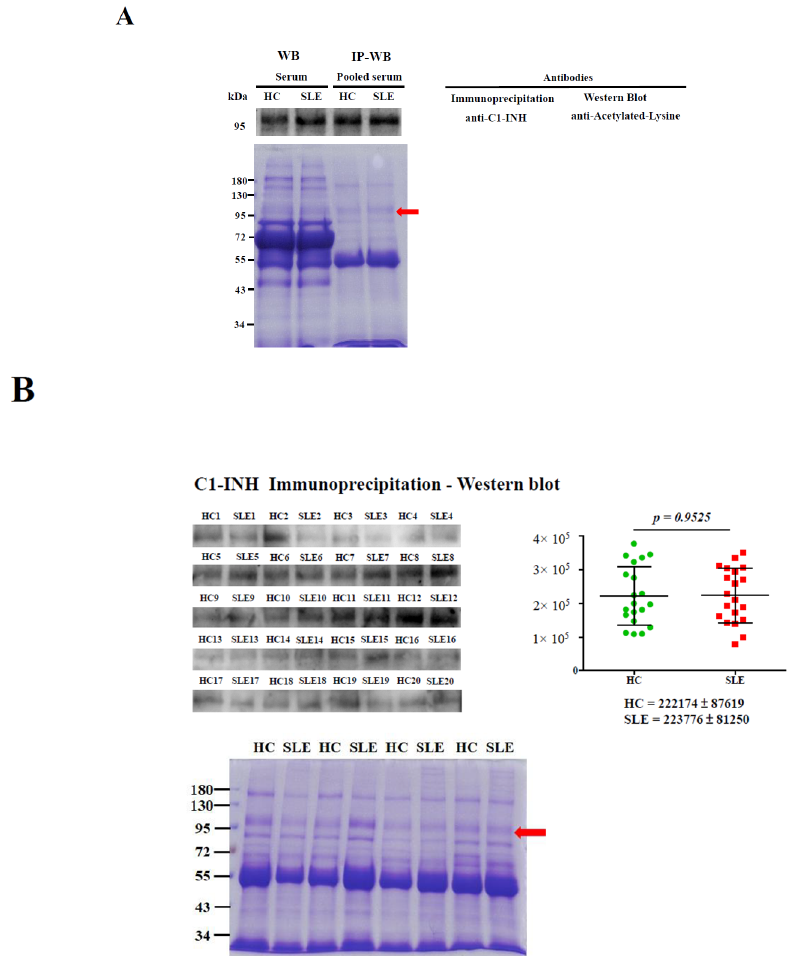
Figure 2. Acetylation modification of the C1-inhibitor (INH) validated using immunoprecipitation (IP) and Western blotting. The percentage of sodium dodecylsulfate polyacrylamide gel electrophoresis (SDS-PAGE) gel was 8%, and IP loading amount of serum proteins was 100 µ g of IgG-removal serum proteins. The C1-INH was immunoprecipitated from pooled serum samples (20 healthy controls (HCs) and 20 patients with systemic lupus erythematosus (SLE)) using an anti-C1-INH antibody, and samples were then subjected to Western blotting with an anti-acetylated-lysine antibody (upper panel). Individually selected random serum samples (2 µ g protein of HCs and patients with SLE) were used as